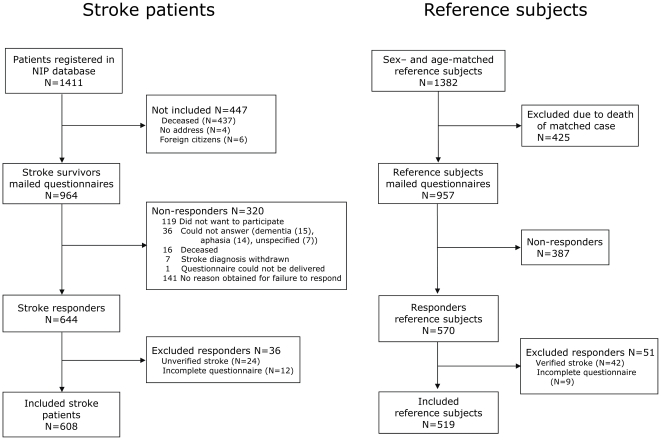
Study flowchart.Study flowchart of stroke patients (left side) and reference subjects (right side).